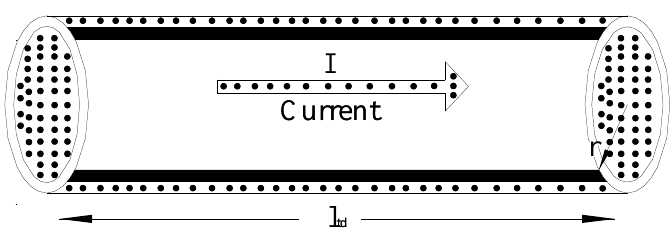
Figure 5. The cylindrical plasma channel model.